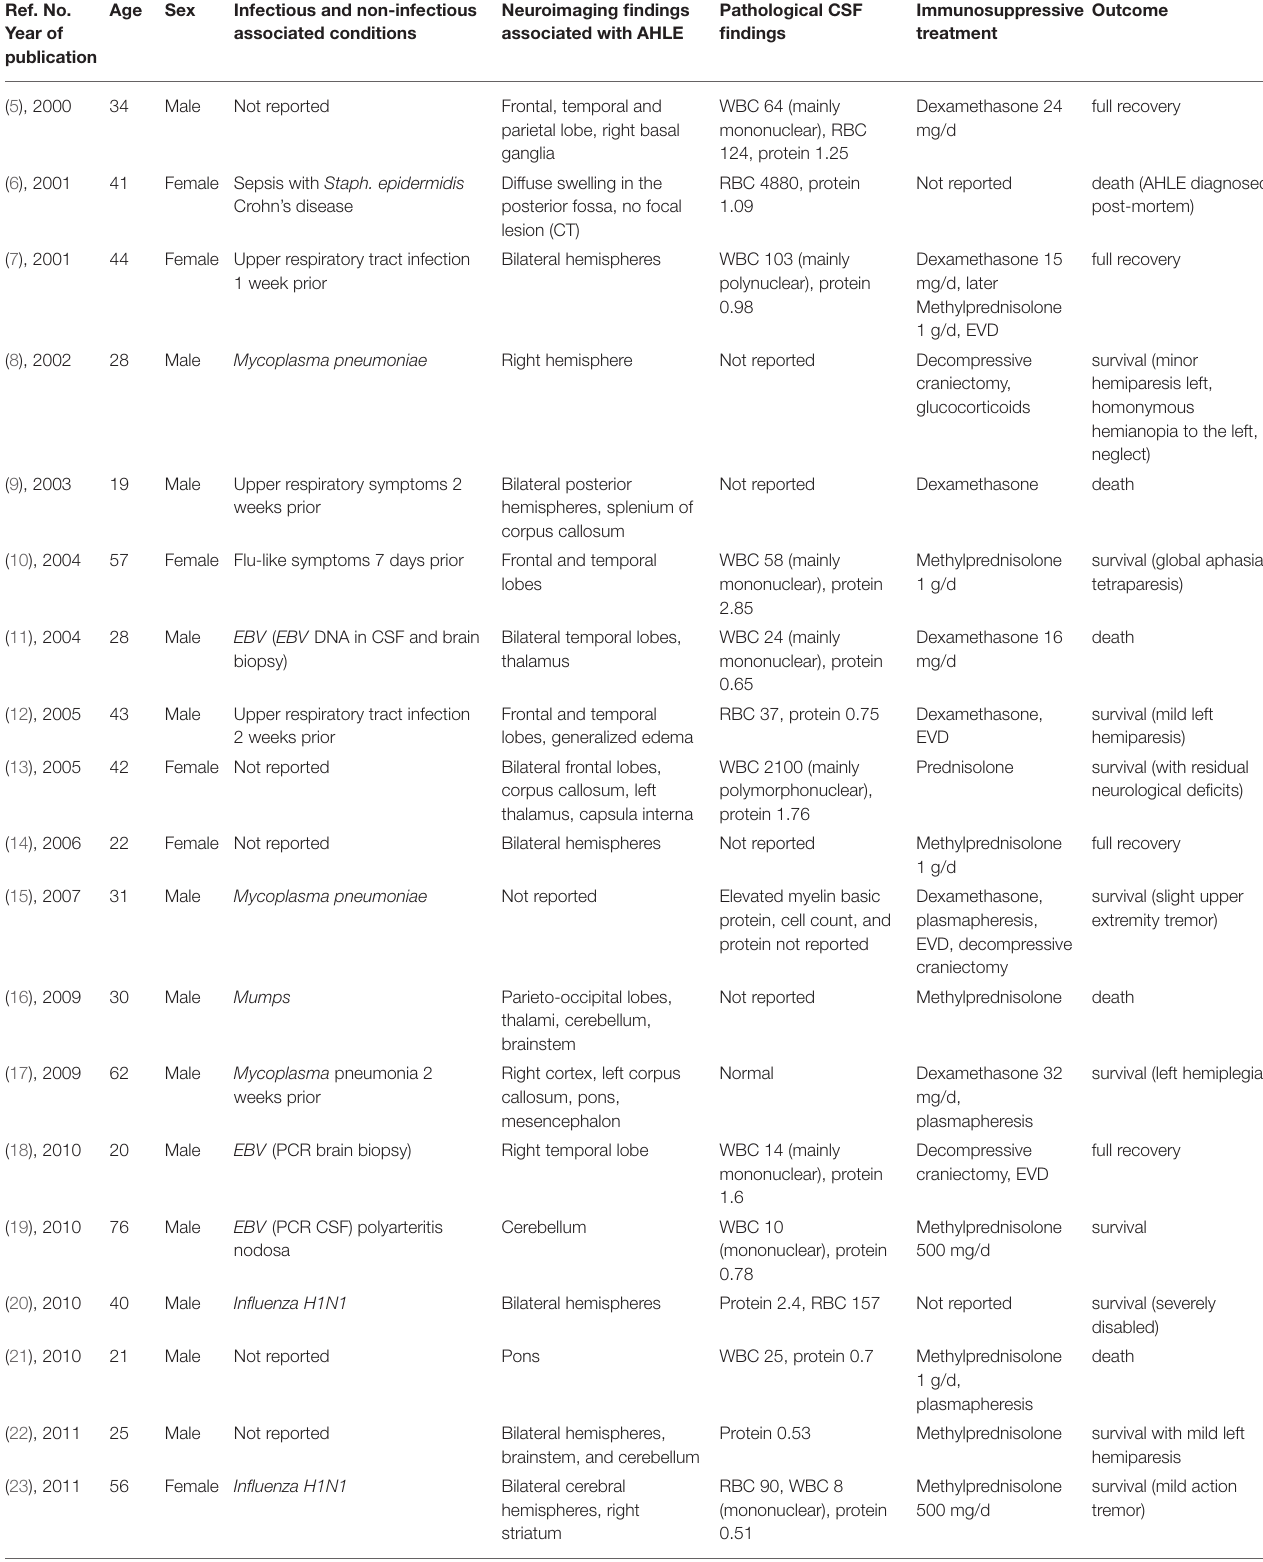
TABLE 1 | Clinical and neuroradiologic characteristics of adult patients with AHLE. Ref. No. Year